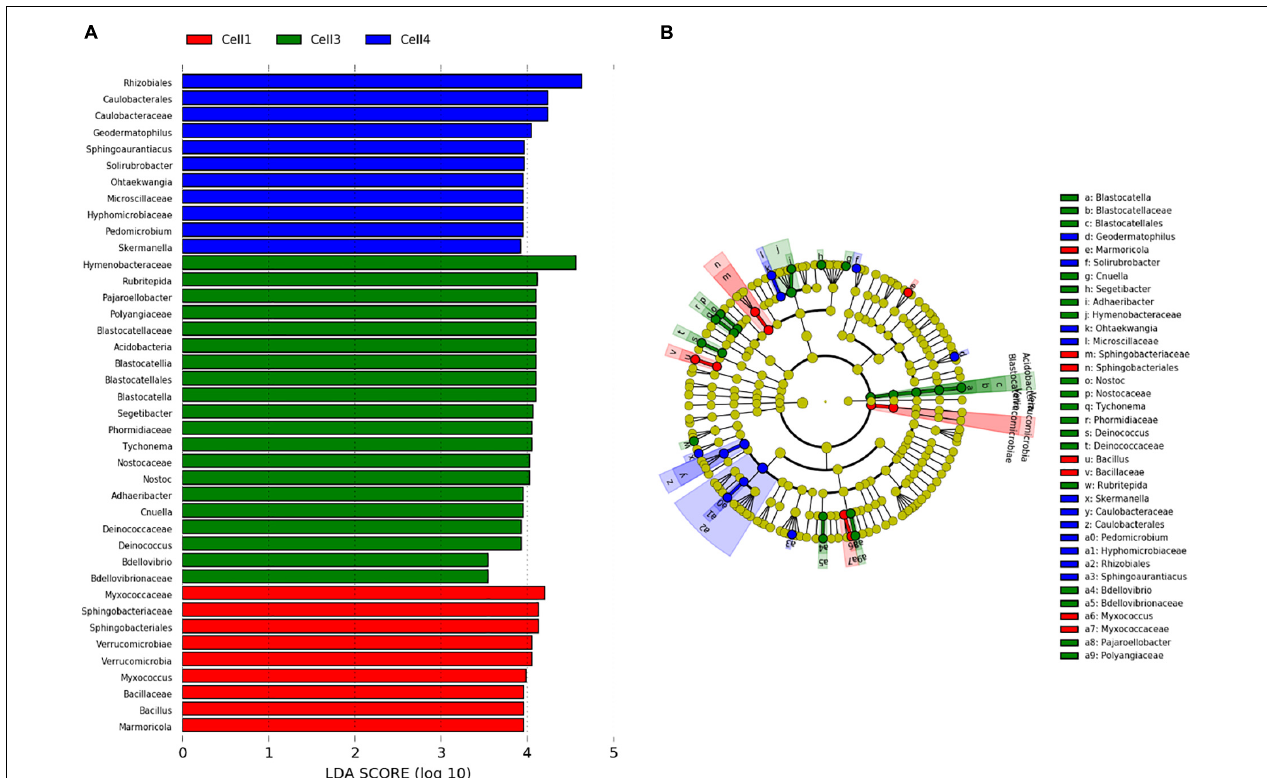
FIGURE 5 | Linear discriminant analysis effect size (LEfSe), (A) chart and (B) cladogram, on microbial diversity in different store-and-release phosphate mine waste layer, overburden waste rock (cells 1 and 4), and phosphate mine wastes (cell 3) produced during the concentration